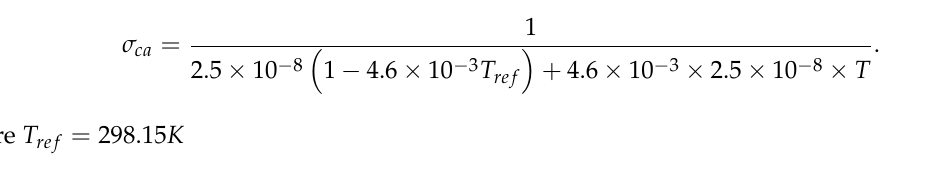
Table A5. List of thermal property